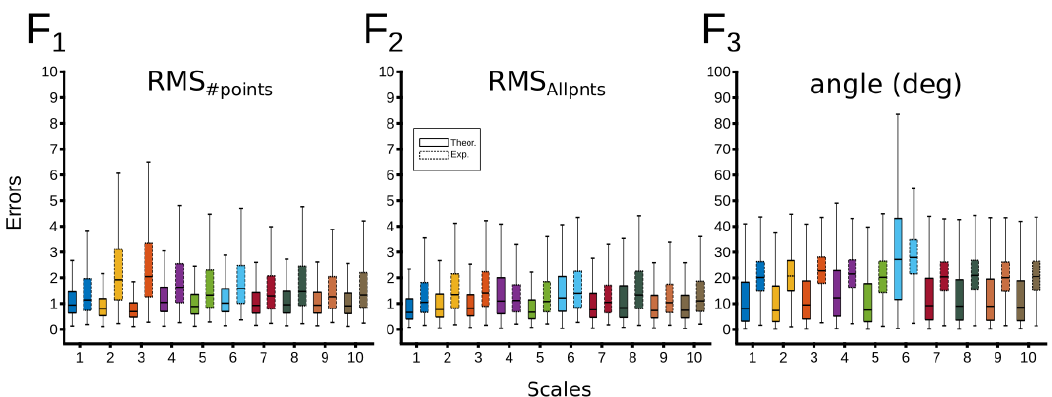
Figure 5. Experimental validation of computational simulations. ( A ) Experimental setup. Visual stimuli presented to cortical neurons in anesthetized cats. Contrast stimuli were presented randomly. ( B ) Representative raster plots of cortical neural responses. ( C ) CRF of recorded neurons, considered as the ground truth curve. Arrows indicate contrast used in ( B ). ( D ) Representative comparison between the empirical CRF (ground truth, black line) and the ten tested scales (color lines from scale 1 to 10). Errors are indicated in each subplot. Number of trials, number of points and trial length were similar across CRFs. ( E1 – E3 ) Average errors of scales across all patterns from 42 neurons. Best scales are those minimizing the error. Significant differences between scales are expressed as * p < 0.05; ** p < 0.01. Significant differences for each average error, ( 1 ) RMS #points , p = 1.0 × 10 − 97 ; ( 2 ) RMS Allpnts , p = 2.9 × 10 − 35 ; ( 3 ) Angle, p = 2.6 × 10 − 245 ; One-way ANOVA. ( F1 – F3 ) Boxplots between simulated (solid line) and empirical (dashed line) data for the 3 different errors across the scales. Lines inside boxplots show medians, and whiskers indicate 95% confidence